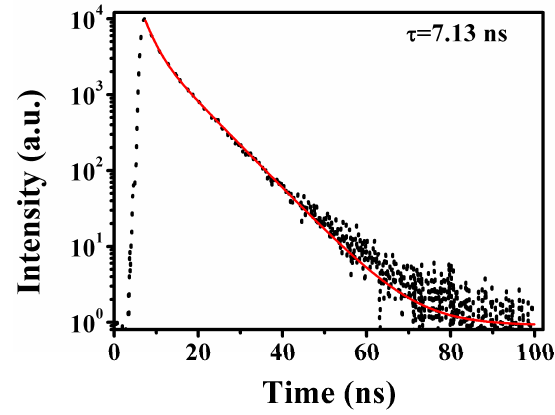
= 4 mL, T = 180 ◦ C, D (EDA)